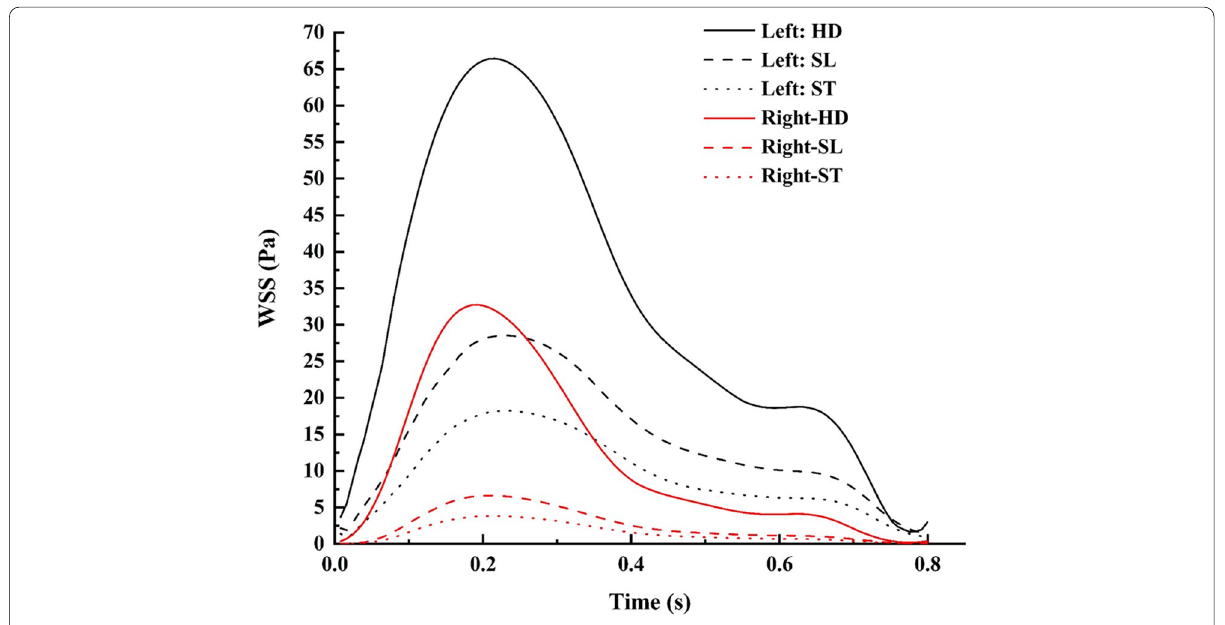
Fig. 9 WSS comparison for various postures